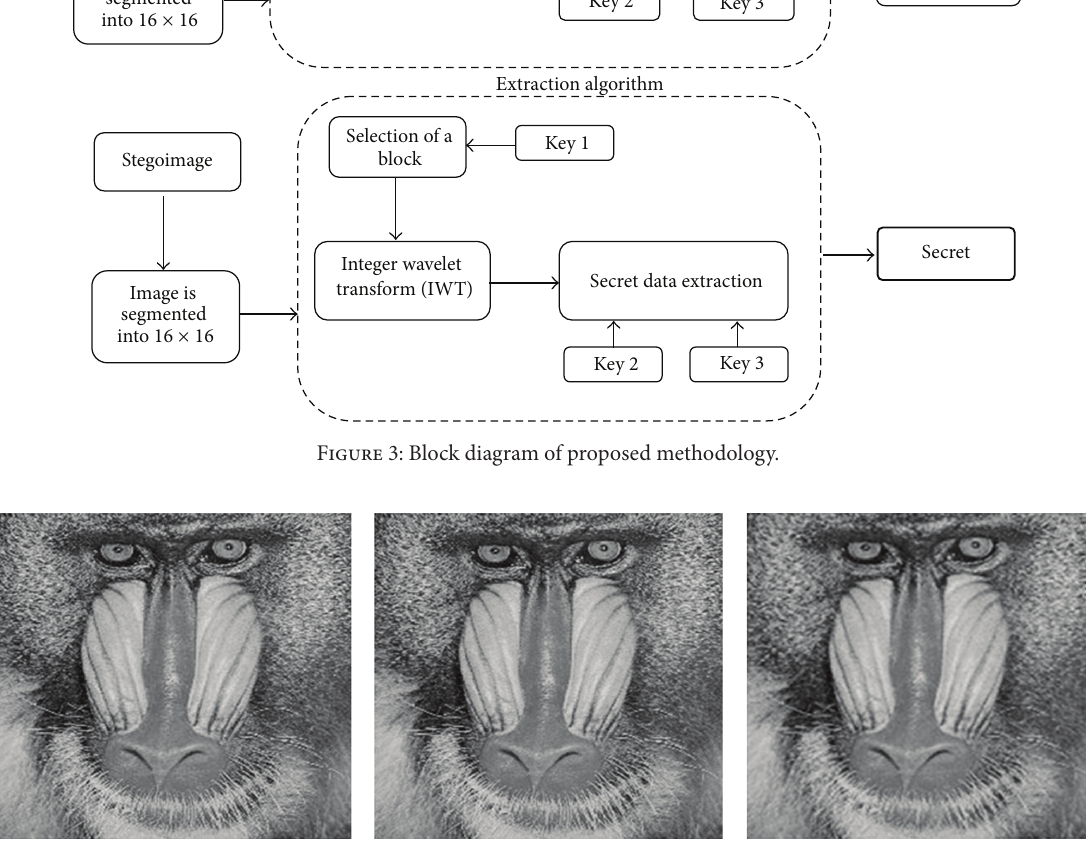
co-efficient ( 𝐶 ). Repeat this procedure for all the 𝐶 values and the remaining